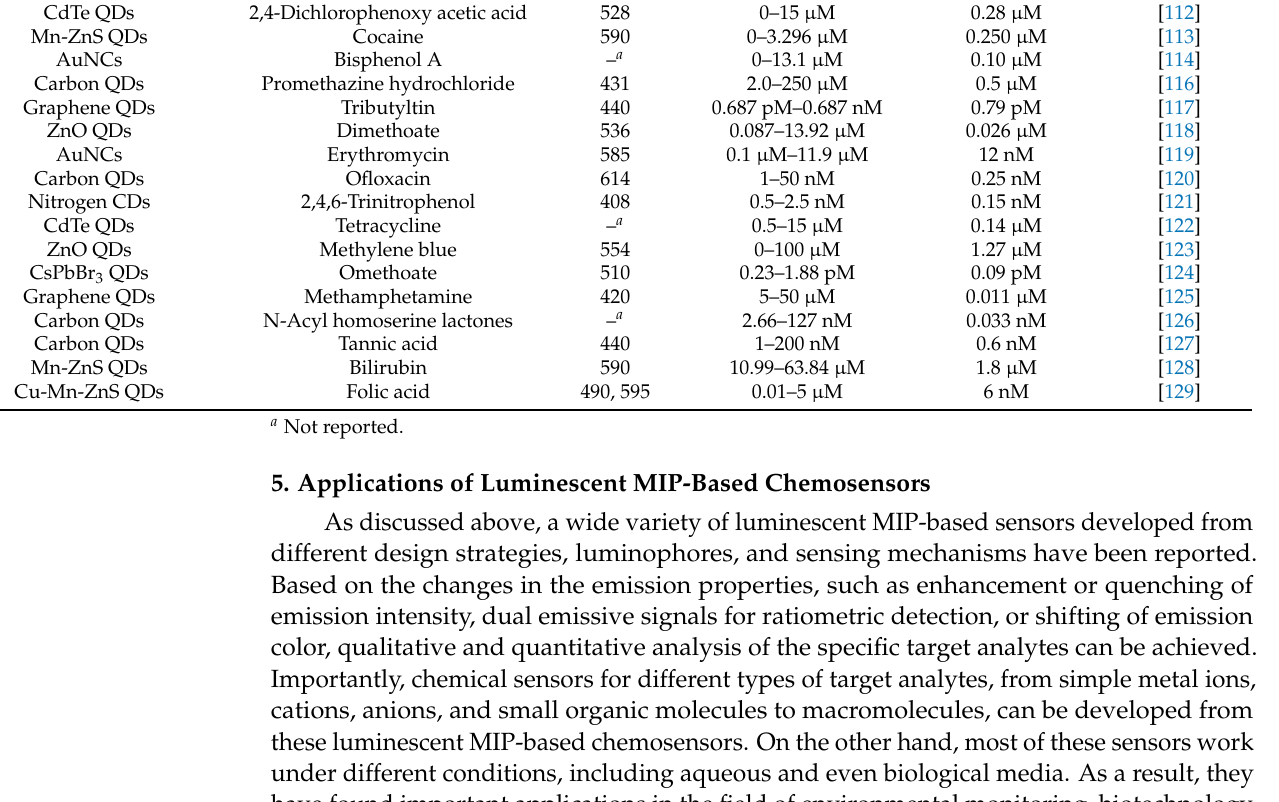
Table 4. Selected examples of typical luminescent nanomaterials-based MIP chemical sensors. Luminescent